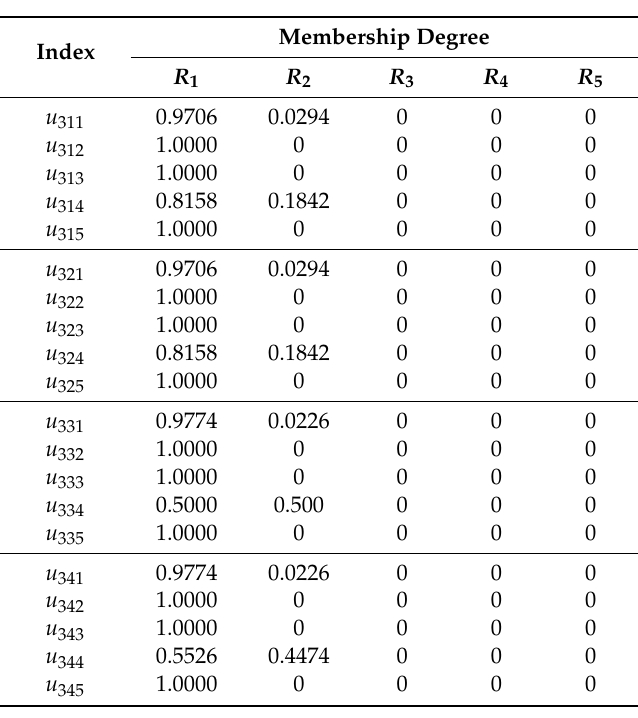
Table 11. Membership degrees of switch influencing factors (R u 3